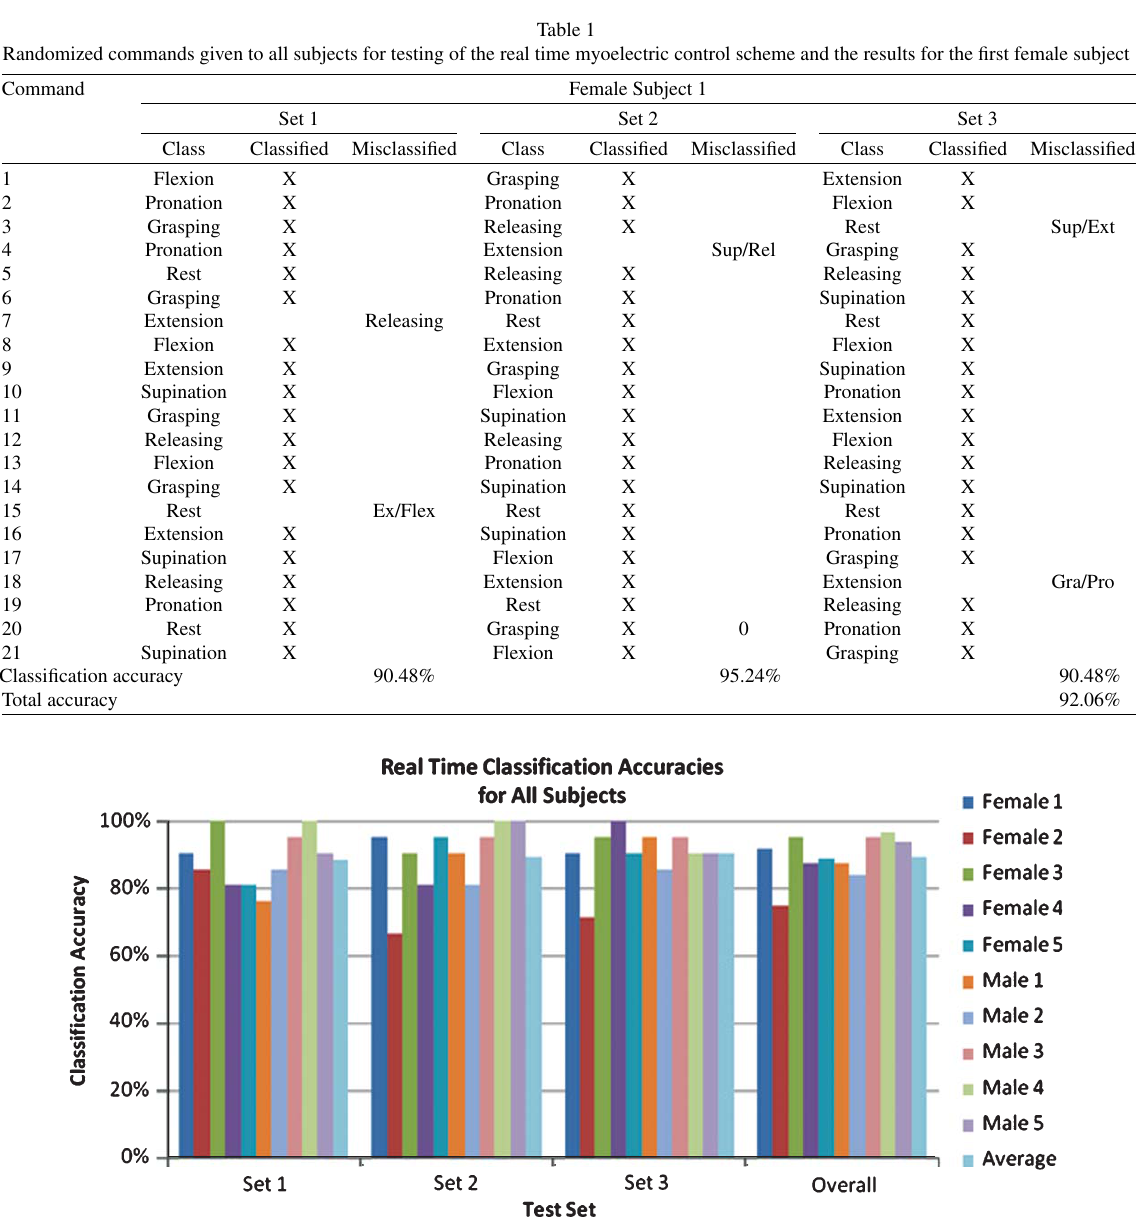
Fig. 7. Real time test results for all of the healthy subjects shown as individual test sets and overall averages. of neurons in the TDNN did not result in a change of the errors for each specific motion and each joint over accuracy. Therefore, it has been chosen to only show the different TDNNs for Subject 1. For simplicity in the results corresponding to the TDNNs with 10 neu- presenting the results, only the detailed results for the rons in the hidden layer. Table 2 displays the combined TDNNs having 100 ms as the delay interval are shown average error for the shoulder and elbow combined for in Table 3. This was chosen due to the fact that the Subject 1 while varying the total delay and the delay 100 ms delay interval performed slightly better than interval. Table 3 presents a more detailed breakdown of the 50 ms and 150 ms intervals as seen in Table